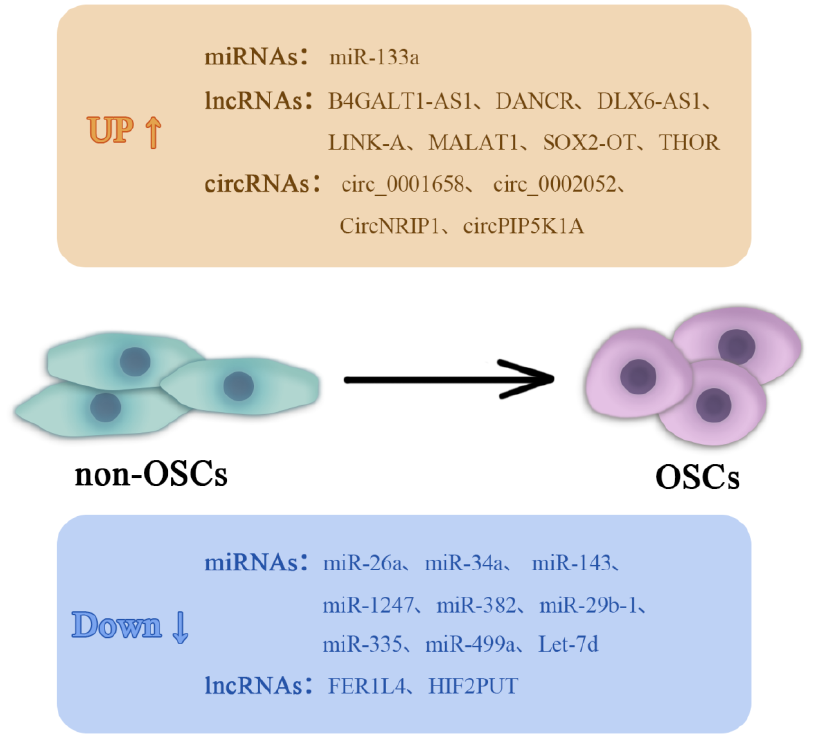
Figure 2. Key non-coding RNAs in non-OSC and OSC interconversion signaling. A series of studies have reported that a number of non-coding RNAs, including microRNAs, lncRNAs and circRNAs, can participate in the OSC interconversion mechanism. OSC, osteosarcoma stem cell; lncRNA, long non-coding RNA; circRNA, circular RNA; AS1, antisense 1; B4GALT1, β -1,4-galactosyltransferase 1; DANCR, differentiation antagonizing non-protein coding RNA; LINK-A, long intergenic non- coding RNA for kinase activation; MALAT1, metastasis-associated lung adenocarcinoma transcript 1; Sex-determining region Y-box 2 overlapping transcript; THOR, testis-associated oncogenic lncRNA; NIRP1, Nuclear receptor interacting protein 1; PIP5K1A, Phosphatidylinositol-4-Phosphate 5-Kinase Type 1 α ; let, lethal; FER1L4, fer-1 family member 4; HIF2PUT, hypoxia-inducible factor-2 α promoter upstream transcript.